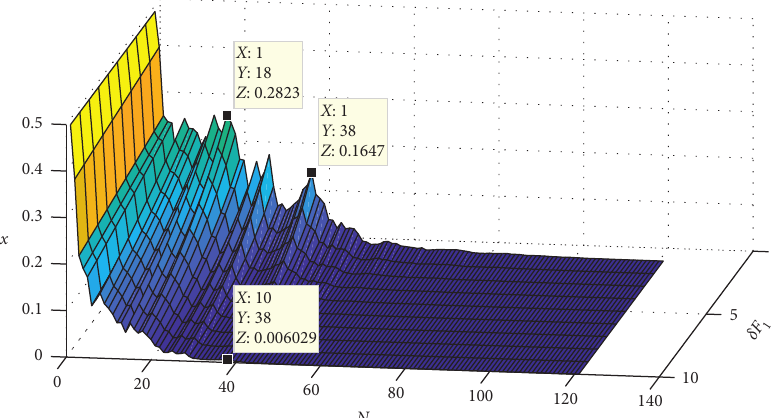
Figure 4: The impact of the regulatory punishment ( δ F